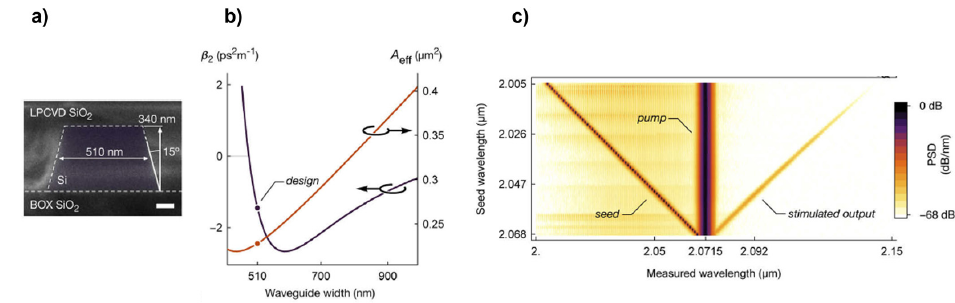
Figure 15. ( a ) Scanning electron micrograph of the image of the waveguide cross section obtained with a scanning electron microscope (scale bar 100 nm). ( b ) Simulation results of the group velocity dispersion β 2 and effective modal area A eff for different waveguide’s widths. The height and side-wall angle of the waveguide are 340 nm and 15°, respectively. ( c ) Measured normalized power spectral density of broadband stimulated four-wave mixing. The pulsed pump has a wavelength of 2.071 µm; a stimulating tunable seed laser was swept at wavelength ≤ 2.071 µm to obtain the stimulated emission at wavelength ≥ 2.071 µm. Adapted and reproduced with permission from [73], copyright 2020.